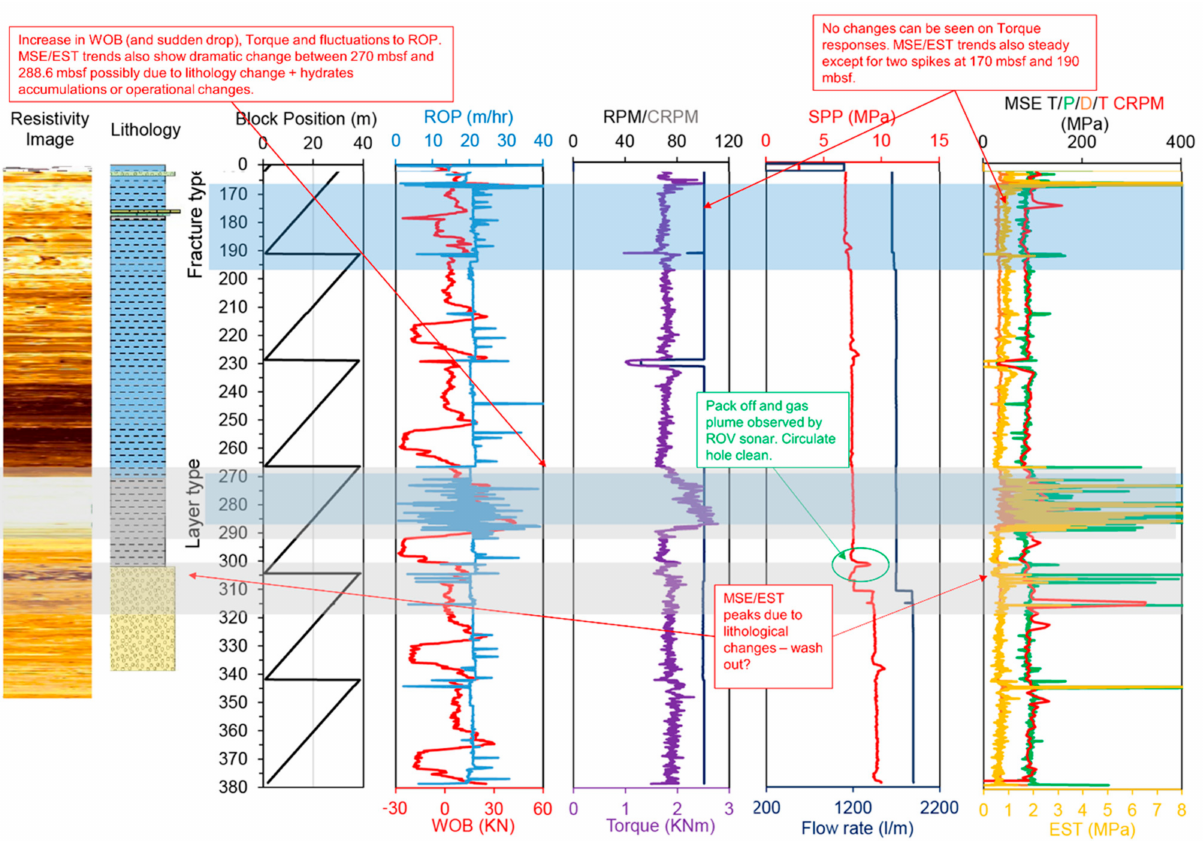
Figure 8. Correlation of drilling parameters and calculated MSE/EST with drilled lithology (blue and grey shaded areas). The green circle and arrow indicate a sudden increase in SPP and potential